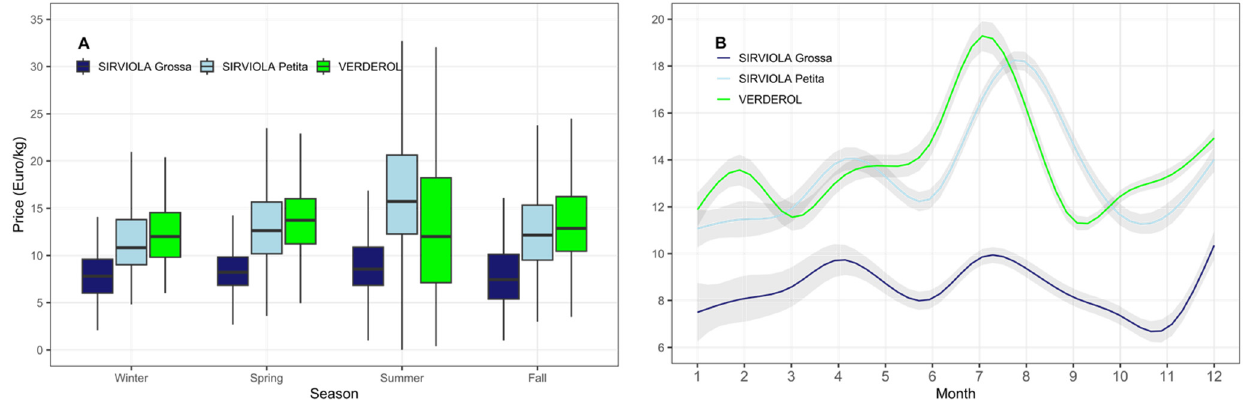
Figure 5. ( A ) Mean price ( € /Kg) for all three size categories by Season ( B ) GAM predicted smooth splines of the response variable mean price of the different categories as a function of month ( p < 0.001).